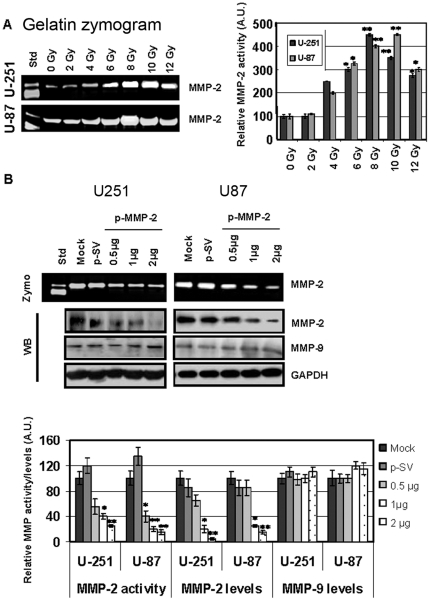
Radiation enhances MMP-2 and p-MMP-2 inhibits MMP-2 activity and expression in glioma cell lines.
A, U-251 and U-87 cells were irradiated with 0–12 Gy X-ray, incubated for 24 h, and conditioned medium collected. MMP-2 activity was determined by gelatin zymography. The band intensities of MMP-2 activity were quantified by densitometry. Columns: mean of triplicate experiments; bars: SD; *p<0.01, **p<0.001, significant difference from non-irradiated (0 Gy) conditioned medium. B, U-251 and U-87 cells were transfected with mock (PBS), p-SV or p-MMP-2 (1, 2 or 3 µg). After 72 h of incubation, conditioned media was used to determine MMP-2 activity by gelatin zymography, and total cell lysates were used to determine MMP-2 and MMP-9 levels by Western blotting. The band intensities of MMP-2 activity as well as MMP-2 and MMP-9 protein levels were quantified by densitometry and normalized with the intensity of the mock bands. Glyceraldehyde-3-phosphate dehydrogenase (GAPDH) served as a loading control. Columns: mean of triplicate experiments; bars: SD; *p<0.01, **p<0.001, significant difference from mock or p-SV.